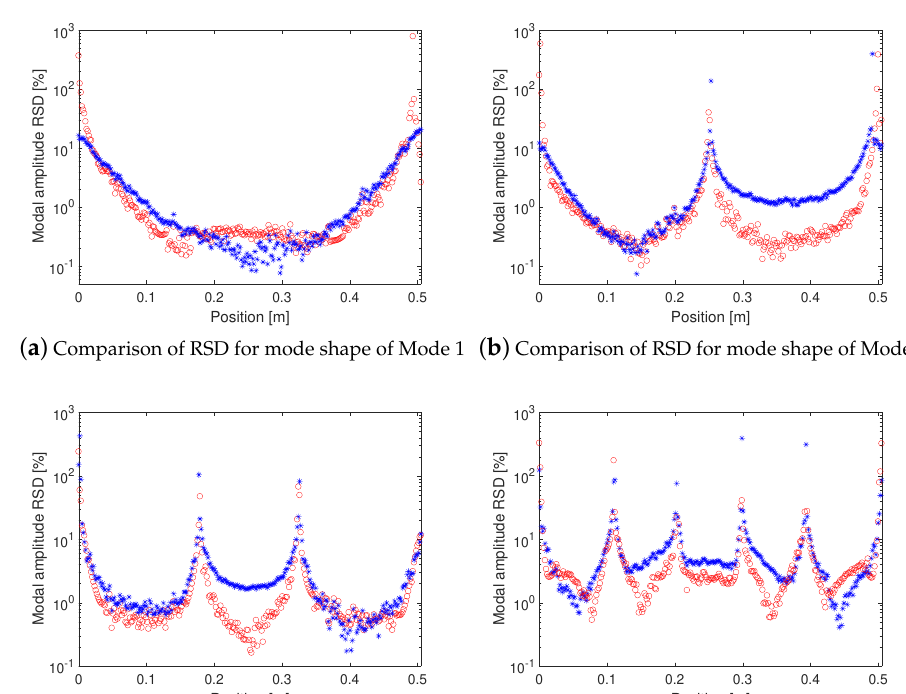
Figure 10. Comparison of different normalization criteria on the dispersion obtained for ten tests for mode shape of Mode 6 of the clamped–clamped beam.